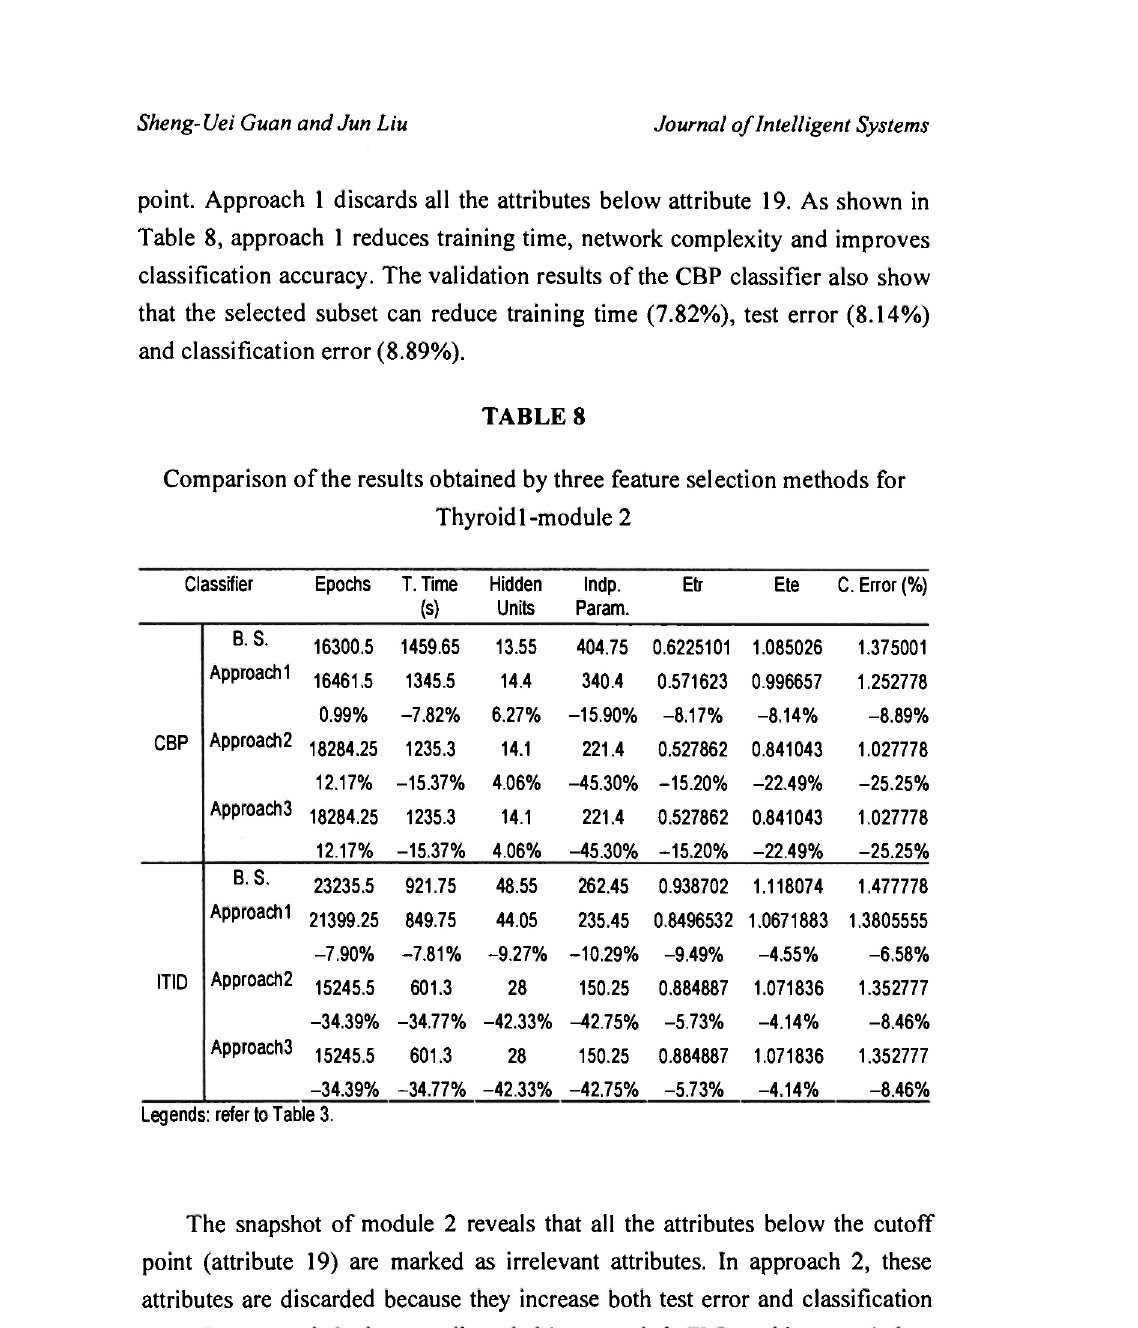
Table 8, approach 1 reduces training time, network complexity and improves classification accuracy. The validation results of the CBP classifier also show that the selected subset can reduce training time (7.82%), test error (8.14%) and classification error (8.89%).